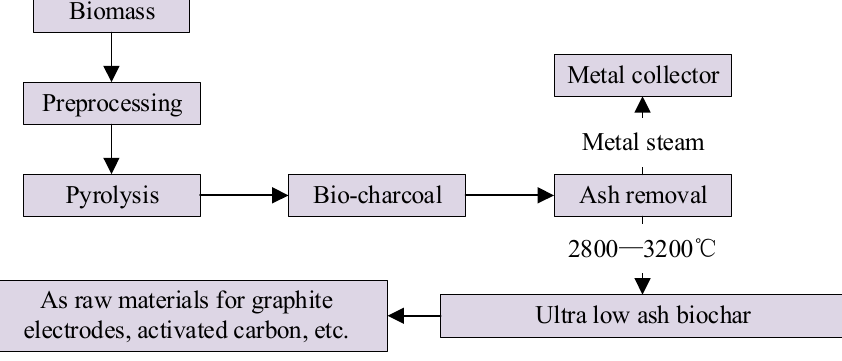
Figure 10. Main preparation process of BC.